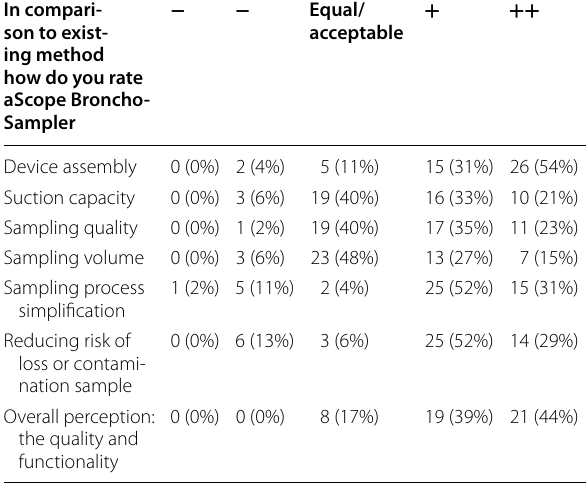
Table 1 Results of the different questions asked to the users in comparison to usual sampling techniques and devices.